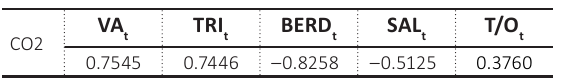
Table 3. Correlation between CO2 emissions